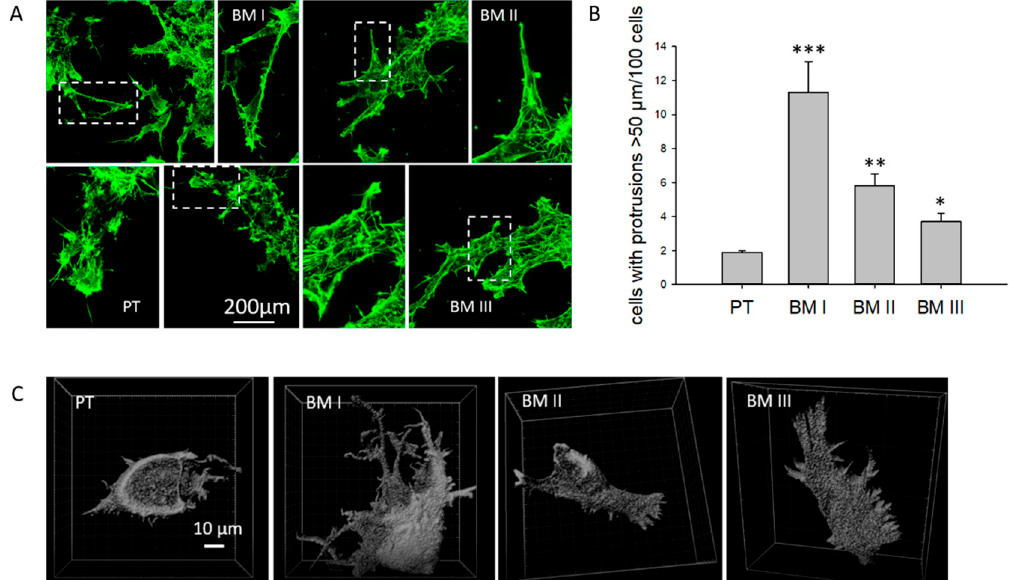
Figure 2. Morphological differences between PT and BM generations. ( A ) F-actin was labeled by Alexa-fluor488 coupled phalloidin (green), and the cells were analyzed by confocal microscopy. The figure includes an overview and magnified images of cell protrusions of each cell line (white frames). ( B , C ) Cells were transfected with F-tractin to label F-actin, imaged by confocal microscopy, and confocal sections were reconstructed to 3D images. ( B ) From these images, the number of cells having protrusions longer than 50 µm was counted. Shown are mean values + SD from 100 cells analyzed in four different experiments. * p < 0.05, ** p < 0.001, *** p < 0.0001.